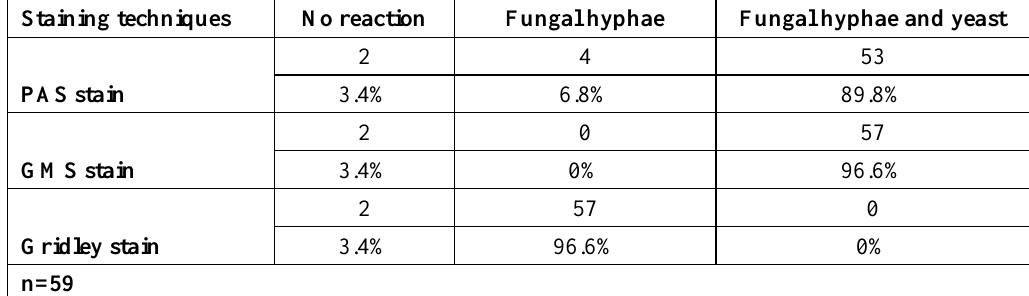
Table 3. The staining reaction of special stains.